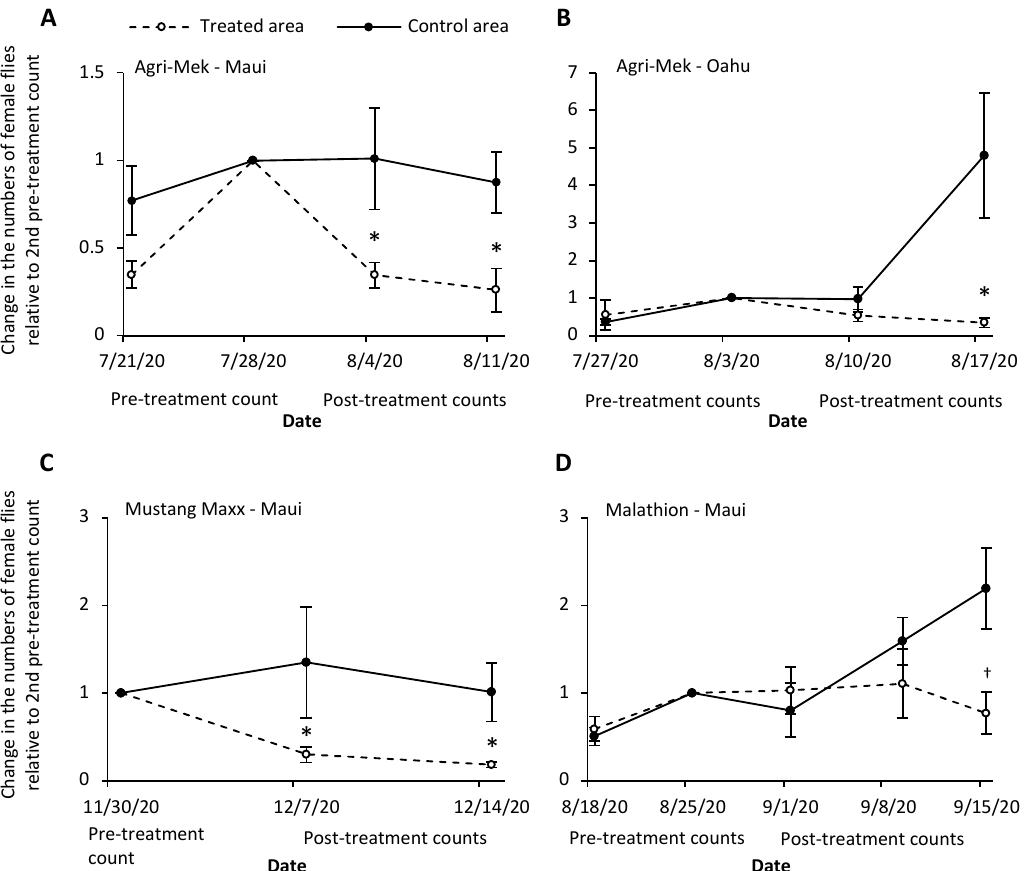
Figure 1. The change in the numbers of female Zeugodacus cucurbitae caught in torula yeast traps relative to the pre-treatment count in the week prior to the first post insecticide-treatment count ( A , Agri-Mek SC Maui commercial farm trial; B , Agri-Mek SC Oahu commercial farm trial; C Mustang Maxx Maui commercial farm trial; D , Malathion 5EC Maui commercial farm trial). The dates (m/d/y) refer to the date that traps were collected and counted; the insecticide was applied one week prior to the post-treatment count date. Grey line represents no change from pre-treatment count. Asterisk above treated area symbols indicates significant difference between control and treated areas based on means contrasts for each date (* p < 0.05, † p < 0.10).